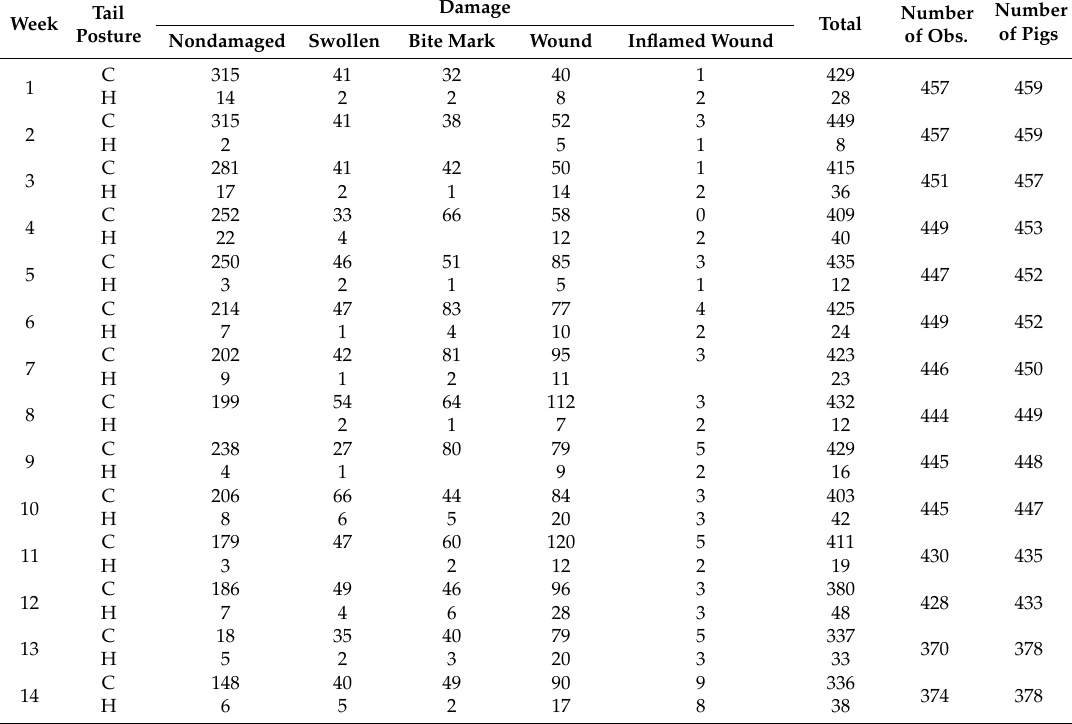
Table 1. Descriptive data of tail damage score in relation to tail posture, presented over the production weeks. Tail posture: C = curled tail and H = hanging tail. Pigs for which no observation was made for tail posture or tail damage were omitted from further observations; consequently, ‘Number of obs.’ and ‘No of pigs’ may differ. Pigs were sent to slaughter in weeks 10, 12 and